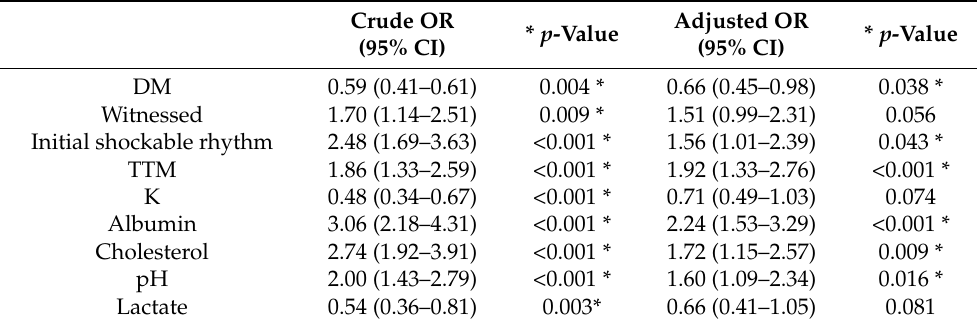
Table 5. Multivariate logistic regression of out-of-hospital cardiac arrest patients with survival to discharge. Crude